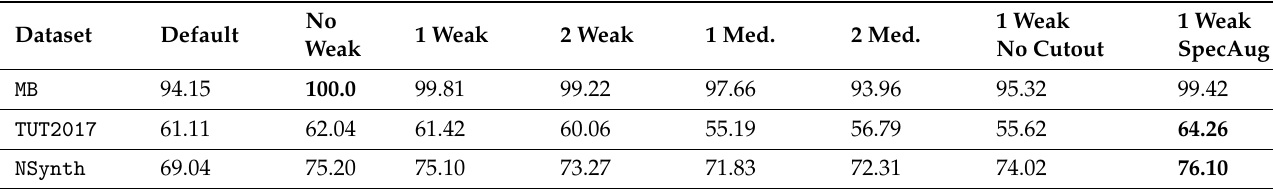
Table 4. Results for different weak augmentation strategies on the test data of each dataset with 5% of the training data, including default (similar to [3]), no weak augmentations, and one or two weak/medium (med.) augmentations applied.